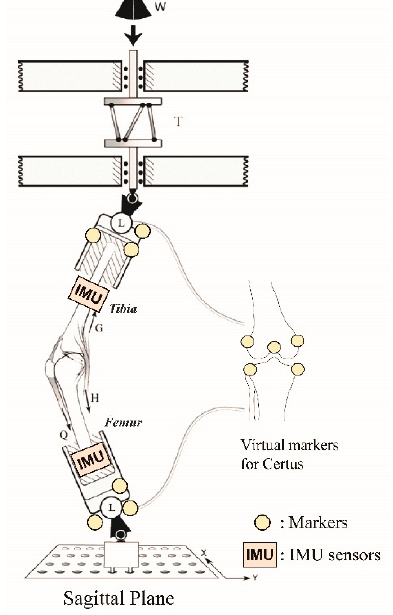
Figure 1. Diagram of the Withrow-Oh testing apparatus [3,20] showing the locations of the fixed active marker triads along with the locations of the virtual active markers obtained by manual digitization prior to the experiment. Modified, and reproduced with permission from [3]. 2011, The Journal of Bone and Joint Surgery, Inc.